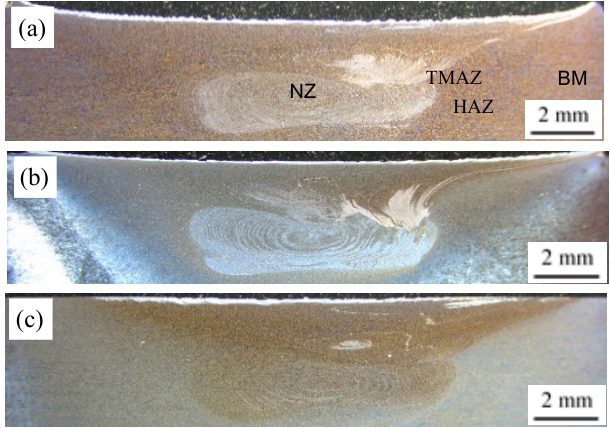
Figure 5. Cross-sectional macrostructures of FSWs under di ff erent states: ( a ) T1; ( b ) T4; ( c ) T6 (The Figure 5. Cross ‐ sectional macrostructures of FSWs under different states: ( a ) T1; ( b ) T4; ( c ) T6 (The advancing side on the advancing side on the right).